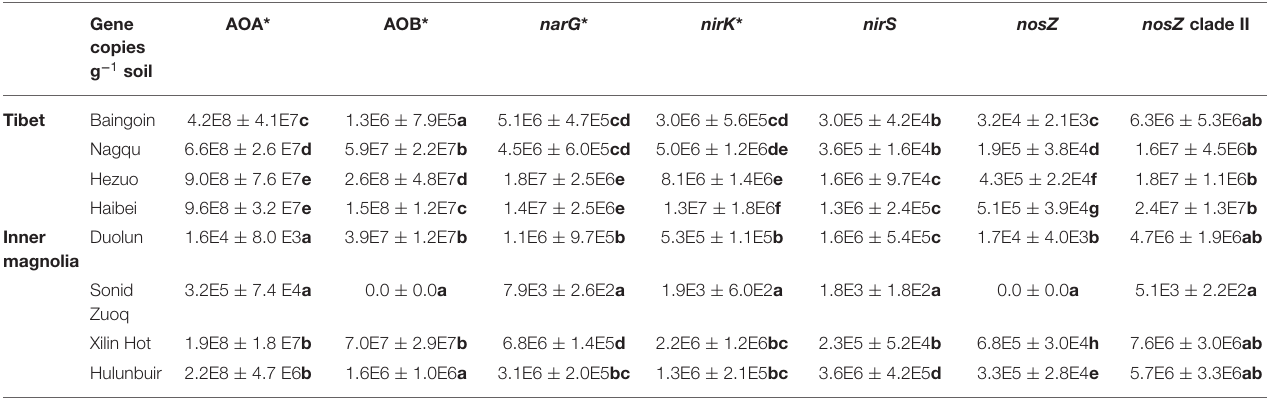
TABLE 2 | Copy numbers of soil microbial functional nitrification and denitrification genes in grasslands. Gene copies g − 1 soil